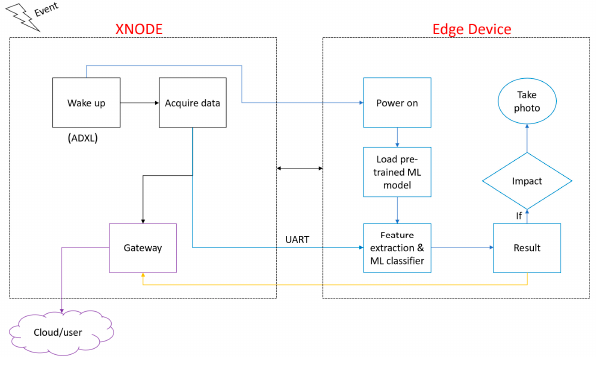
Figure 10. Framework for edge classi fi cation.